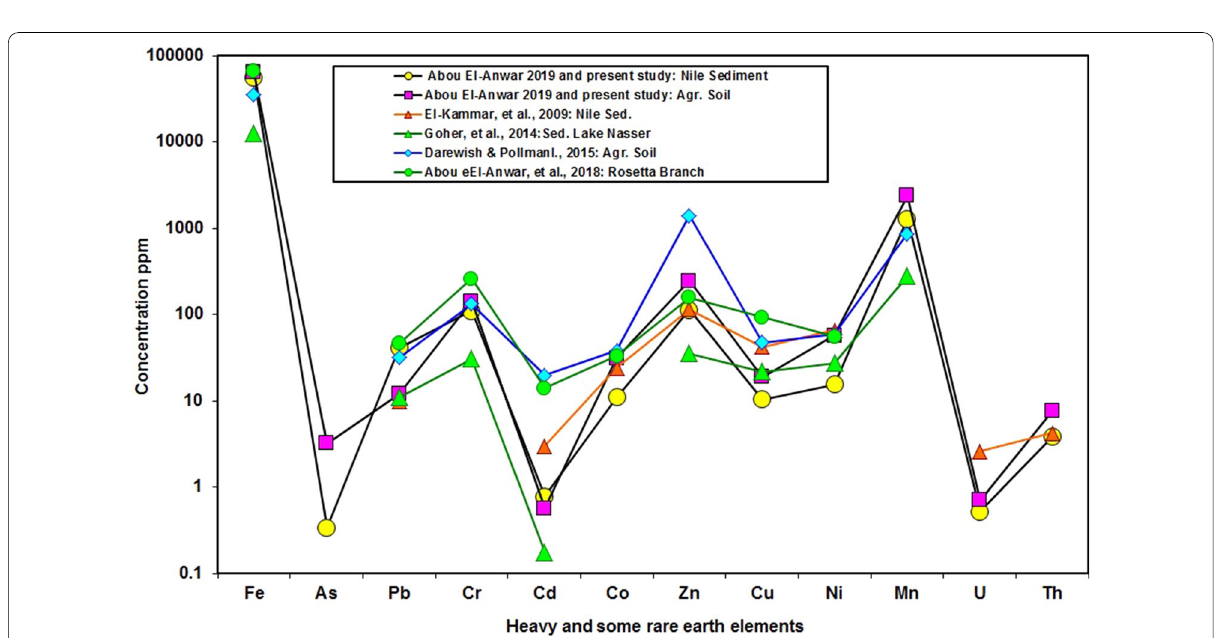
Fig. 5 Comparison the elements (ppm) in the study area with others localities